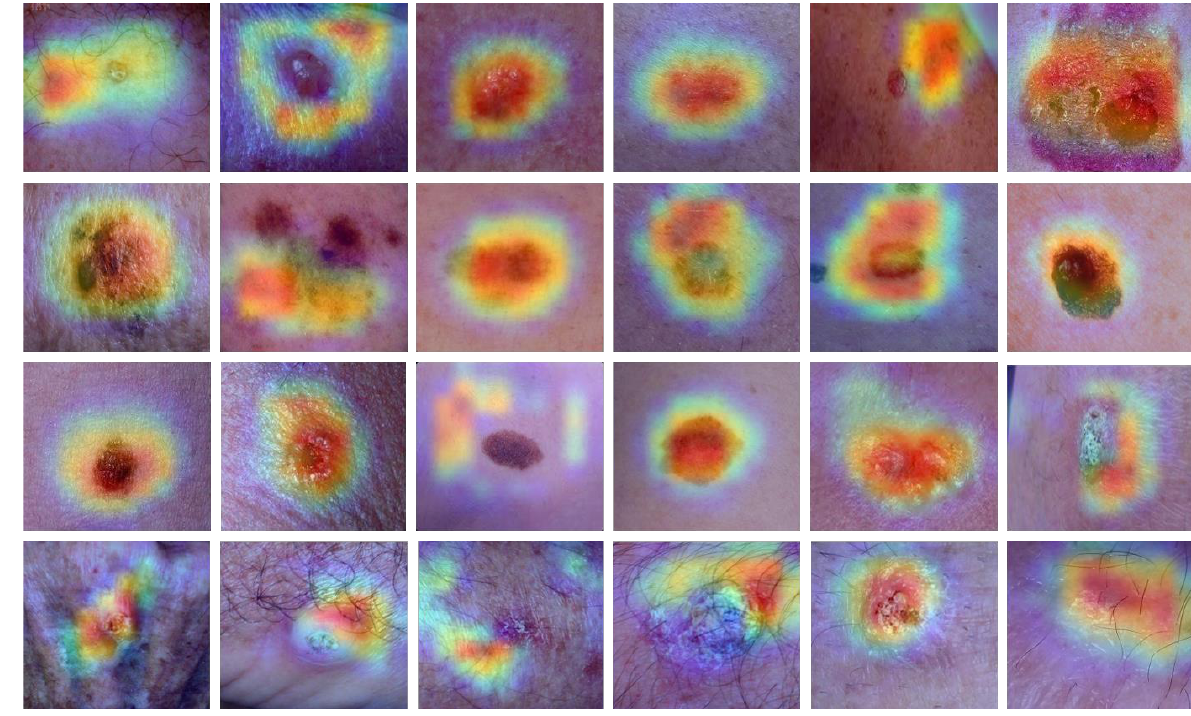
Figure 15. Grad-CAM evaluation of the proposed DSCC_Net model for skin cancer diseases.